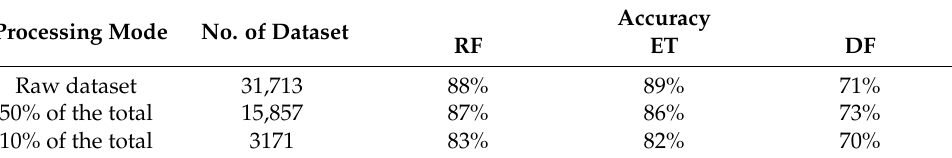
Table 6. Accuracy comparison of ensemble algorithms. Processing